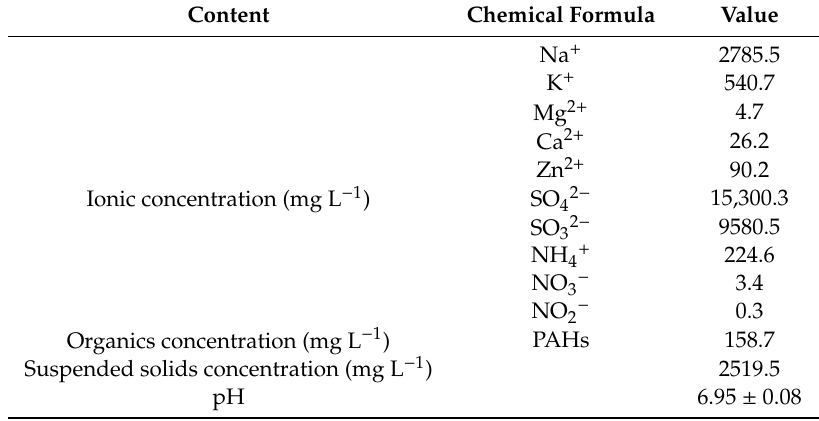
Table 2. The composition and physicochemical properties of the desulfurization